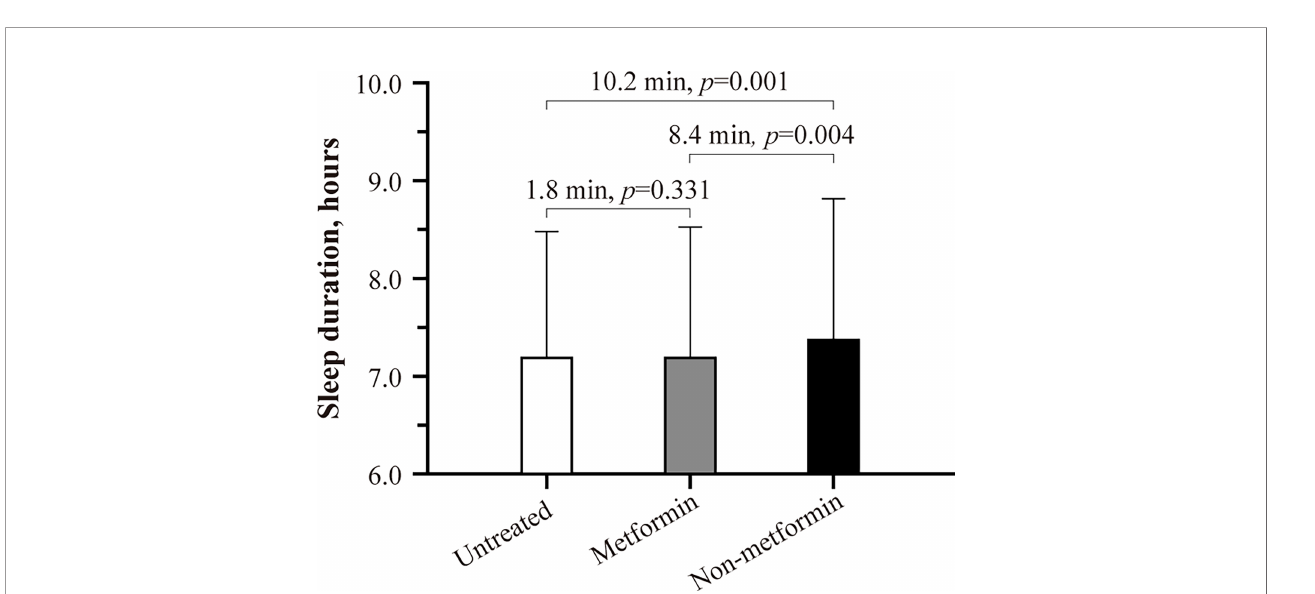
FIGURE 2 | Habitual sleep duration of untreated, metformin, and non-metformin patients with type 2 diabetes. Estimated marginal means ± SE derived from a generalized linear model adjusting for patients ’ age, sex, BMI, UK Biobank assessment center, Townsend index, systolic blood pressure, snoring status, type 2 diabetes duration, HbA 1c , presence of cardiovascular disease, antidepressant therapy status, and statin therapy status are shown. P smaller than 0.05 was considered signi fi